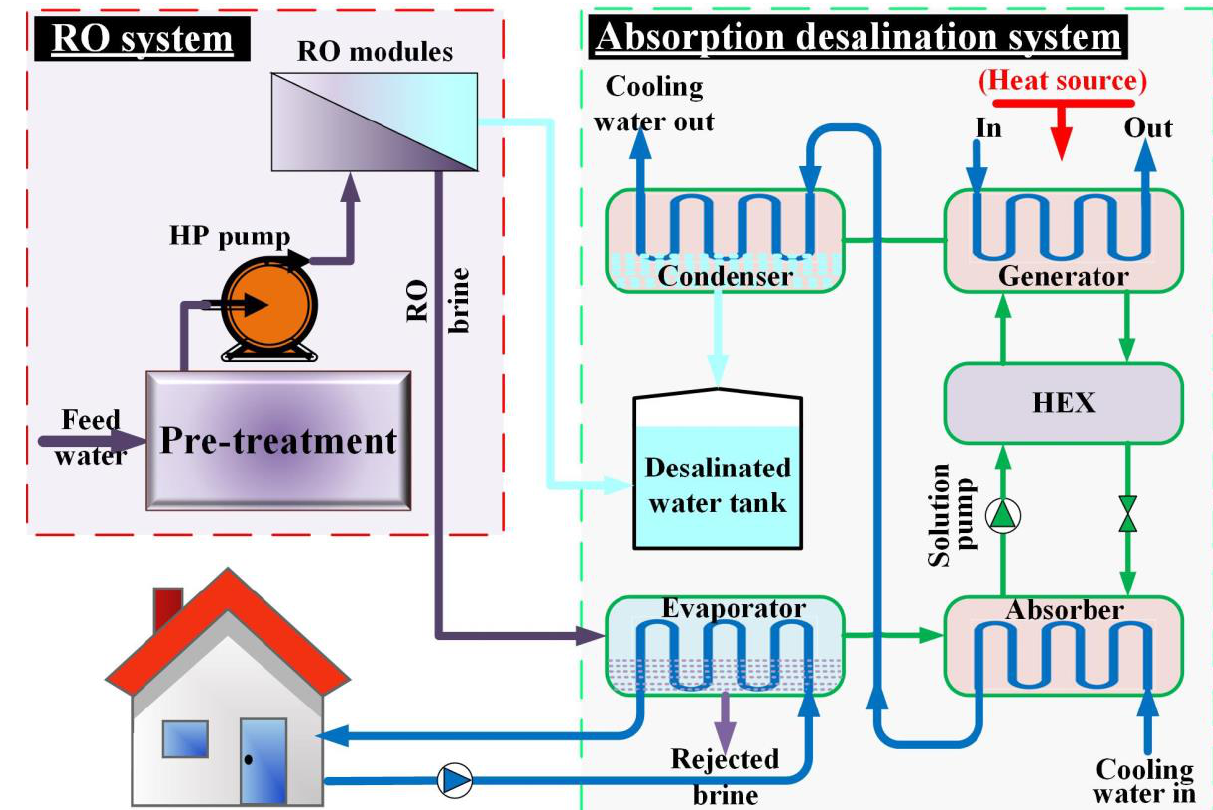
Figure 6. The RO-ABDC system diagram (adapted from [86]).